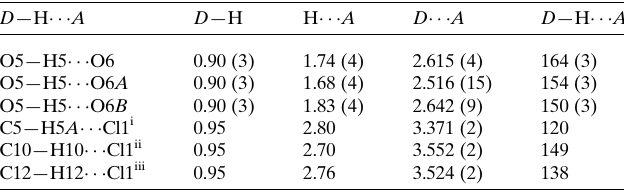
Figure 4 The molecular structure of compound I , with atom labeling and showing the position of the minor component of the disordered benzoic acid group. Displacement ellipsoids are drawn at the 50% probability level.